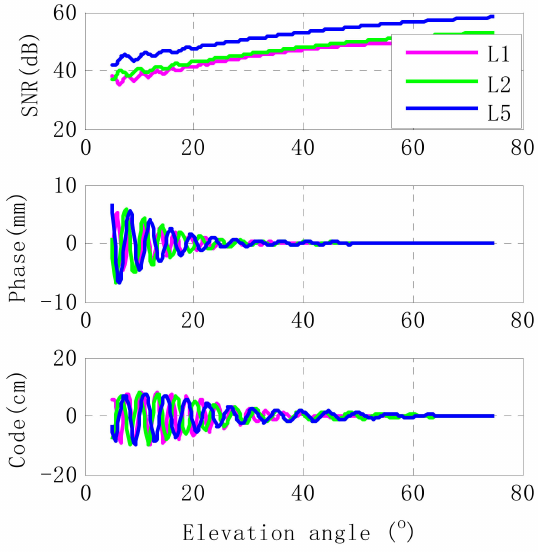
Figure 3. Multi-frequencies effects on GPS multipath signatures in GPS SNR, carrier phase and code pseudorange observables. The L1 band is shown in pink, L2 in green and L5 in